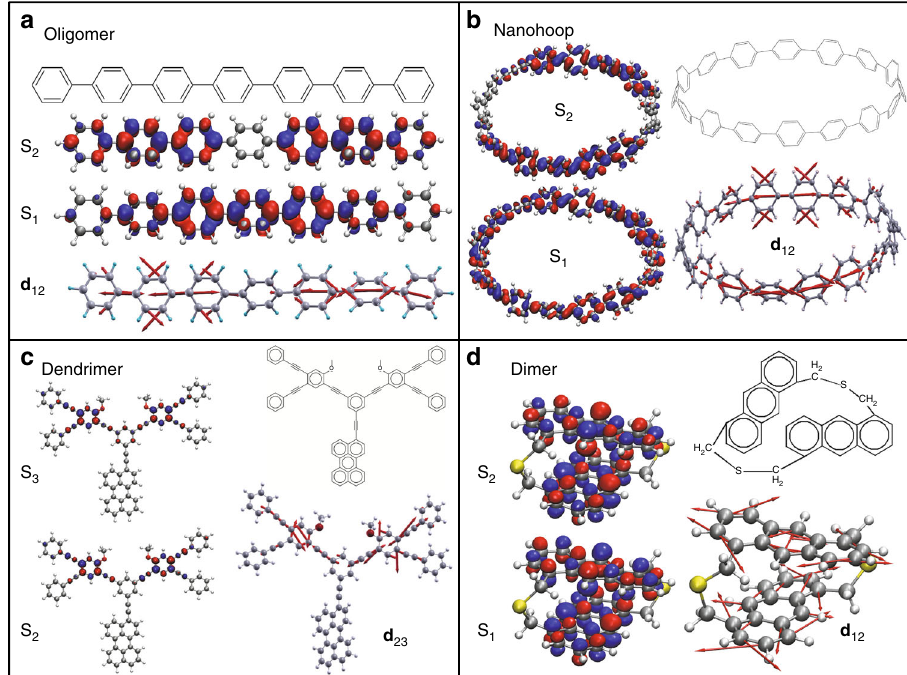
Fig. 2 Characterization of four model systems. a polyphenylene oligomer, b cycloparaphenylene nanohoop, c branched phenylene ethynylene dendrimer, and d anthracene dimer (dithia-anthracenophane); Each panel contains the chemical structure, orbital plots of the transition densities for the two lowest excited states S 2 and S 1 (S 3 and S 2 in dendrimer) at the ground state equilibrium geometry, and the corresponding non-adiabatic coupling vector d 12 ( d 23 in